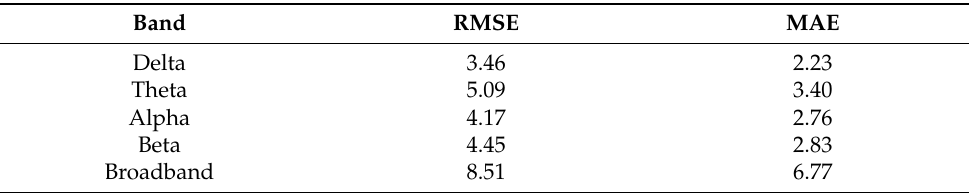
Table 7. BDI regression performance of deep-asymmetry